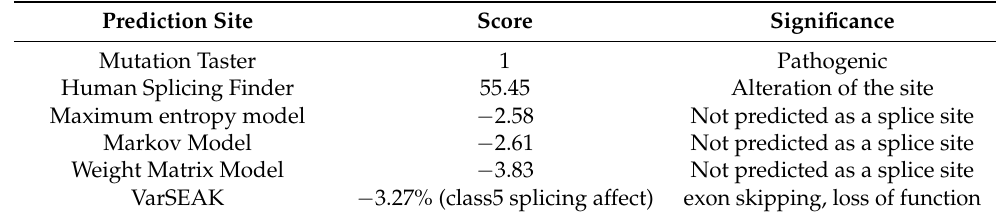
Figure 4. Schematic presentation of possible effect of c.351-1 G>A CHRNG splice site mutation. Hypothesis 1: retention of introns 4–5; Hypothesis 2: exon skipping. Table 3. Prediction of the pathogenicity of the splice site mutation.